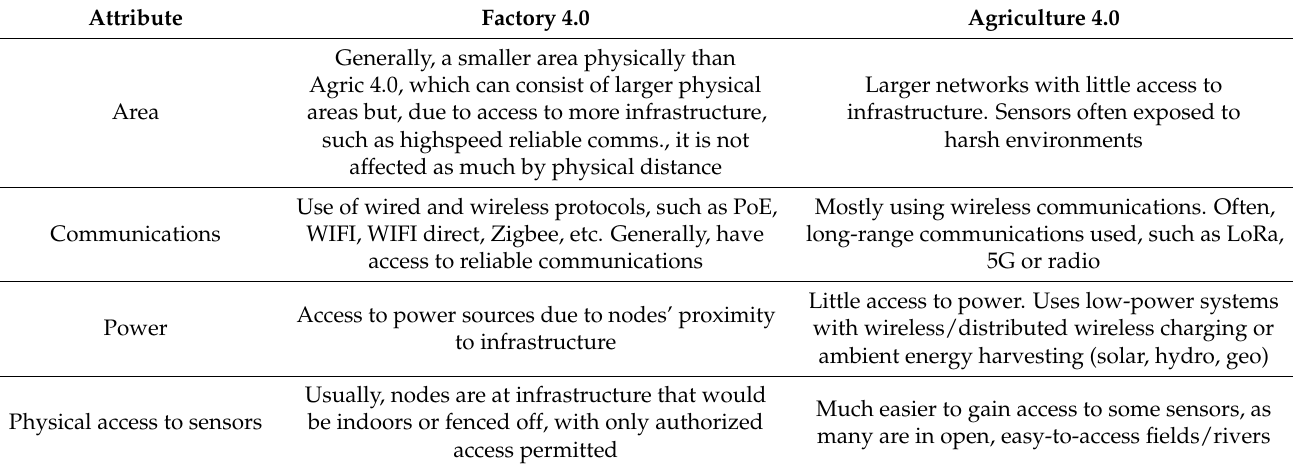
Table 2. Comparison on the Factory and Agriculture 4.0